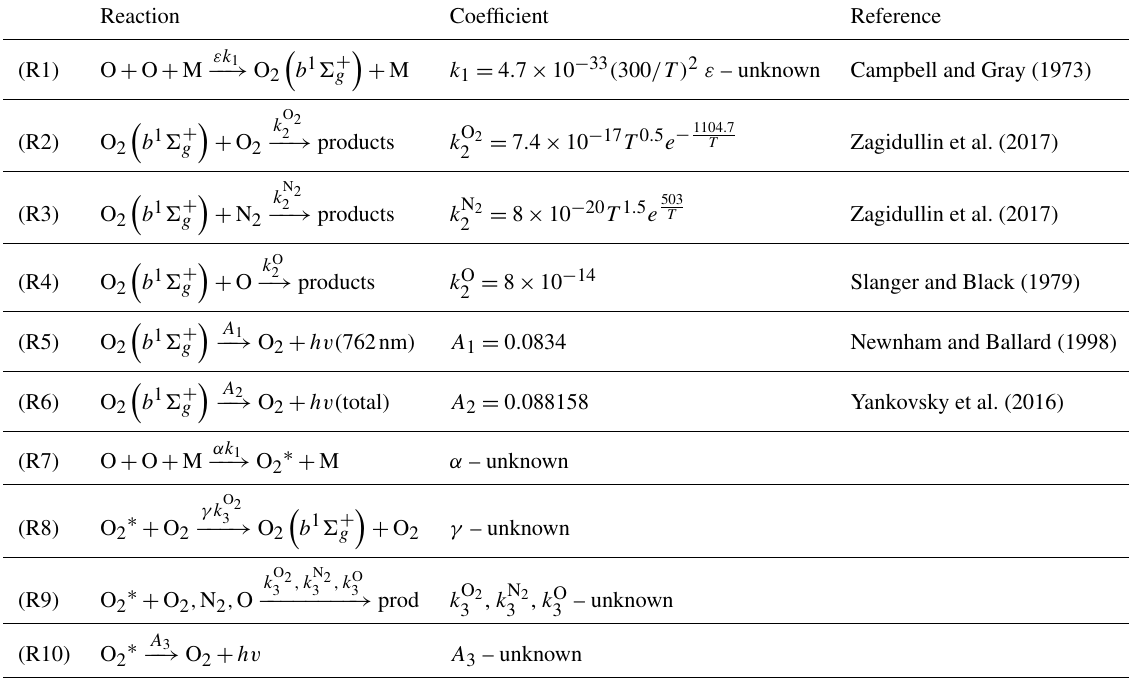
Table 1. List of reactions with corresponding reaction rates (for three-body reactions [cm 6 molecule − 2 s − 1 ] and for two-body reactions [cm